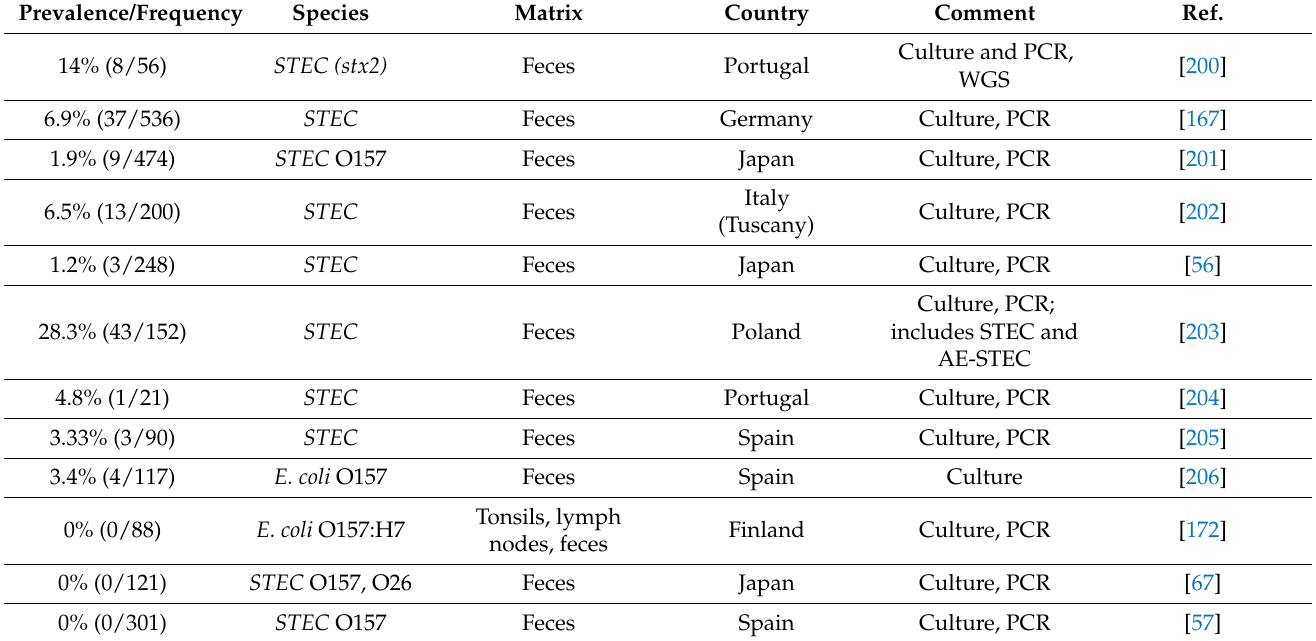
Table 12. Prevalence of Shiga toxin-forming E. coli in wild boar, fecal samples, lymphatic organs, 2012–2022.